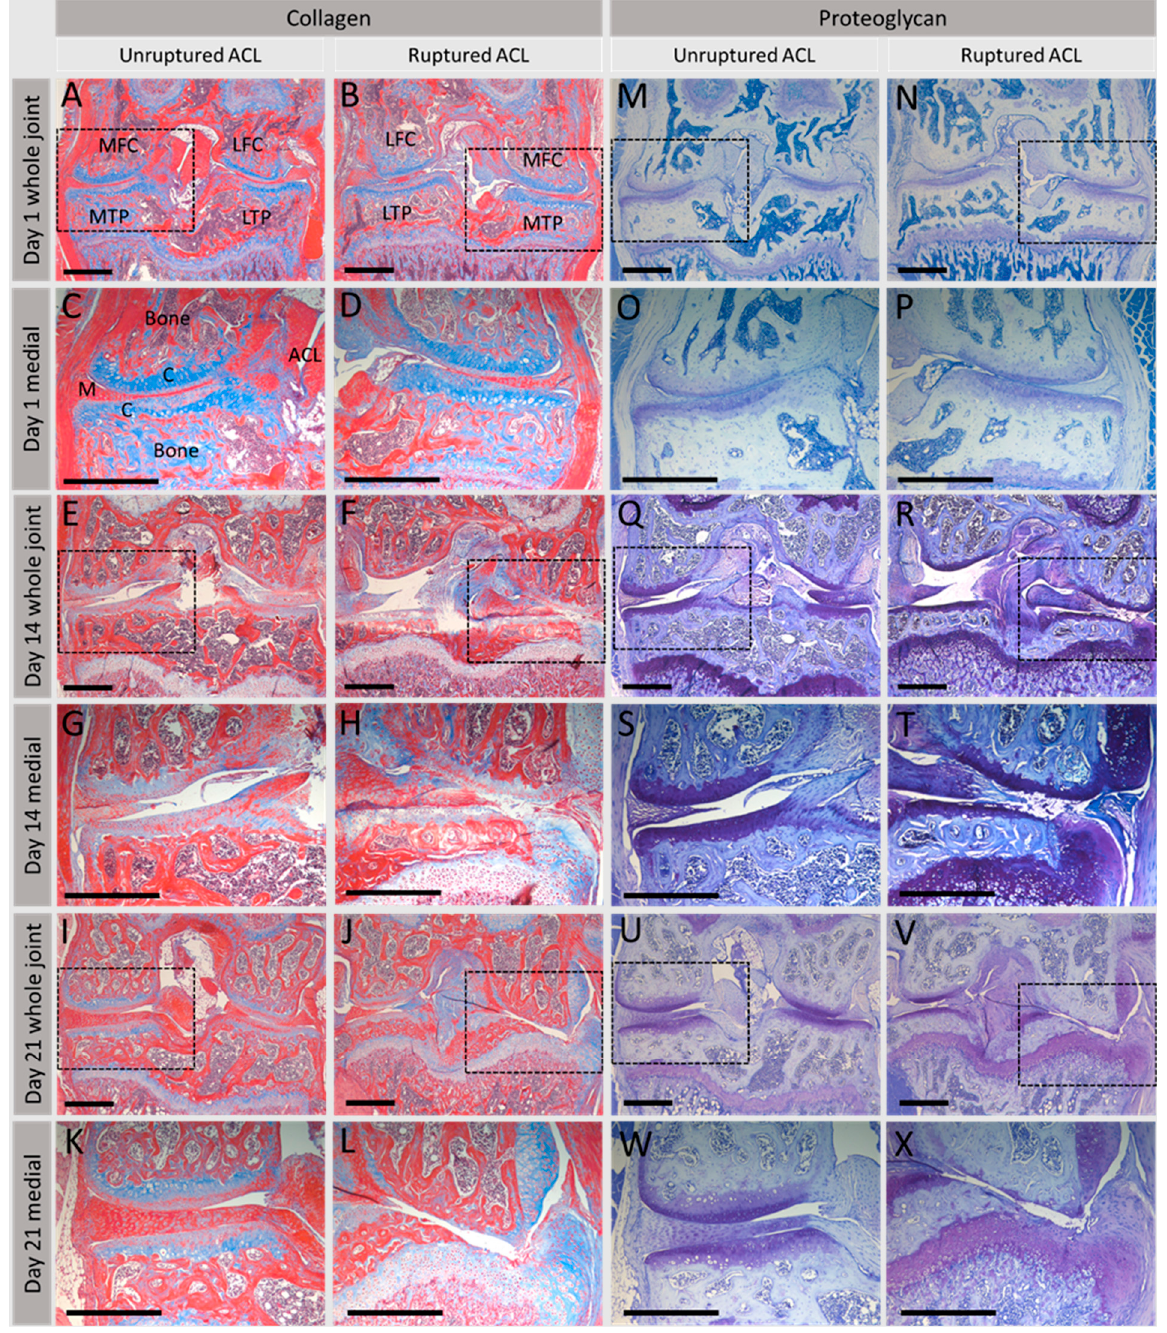
Figure 4. Effect of injurious load on articular cartilage integrity in the synovial joint. Collagen and proteoglycan distribution in an in vivo non-surgical murine model of post-traumatic OA following rupture of the anterior cruciate ligament (ACL) [167]; knee joint integrity was assessed at days 1, 14 and 21 post-rupture and compared to mice with an intact ACL, i.e., unruptured controls. ( A – L ) show collagen (blue) distributed throughout cartilage and bone. On day 1, collagen is located evenly throughout cartilage ( A – D ); however, at day 14 post-rupture (F and H), cartilage fibrillation is evident with loss of collagen, followed by complete loss by day 21 ( J , L ). Proteoglycan distribution (dark blue, ( M – X )) shows a similar distribution throughout the cartilage, evenly distributed at day 1 ( M – P ) but gradual loss as joint damage begins to occur at 14 ( R , T ) and 21 days ( V , X ) post-ACL-rupture. Trichrome stain kit (Abcam, ab150686) was used for collagen staining, toluidine blue for proteoglycans. MFC, medial femoral condyle; LFC, lateral femoral condyle; MTP, medial tibial plateau; LTP, lateral tibial plateau; M, meniscus; C, cartilage. Dashed boxes indicate higher magnification medial compartment images directly below. Scale bars: 500 µm.